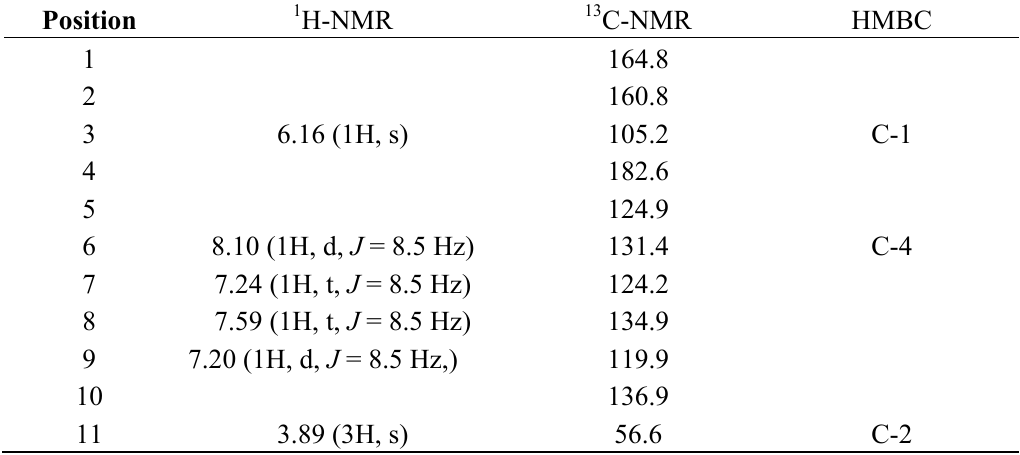
) and 13 C-NMR (125 MHz, CDCl 3